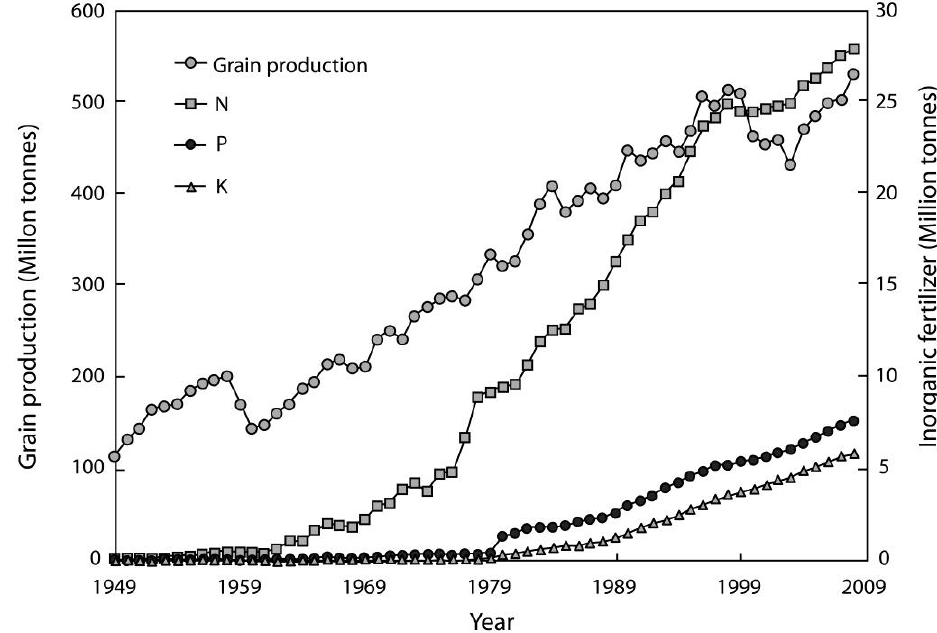
Fig. 6. Crop production and synthetic fertilizer consumption in China (1949-2008)(Source: Sun et al., 2012) N – nitrogen, P – phosphate, K - potassium